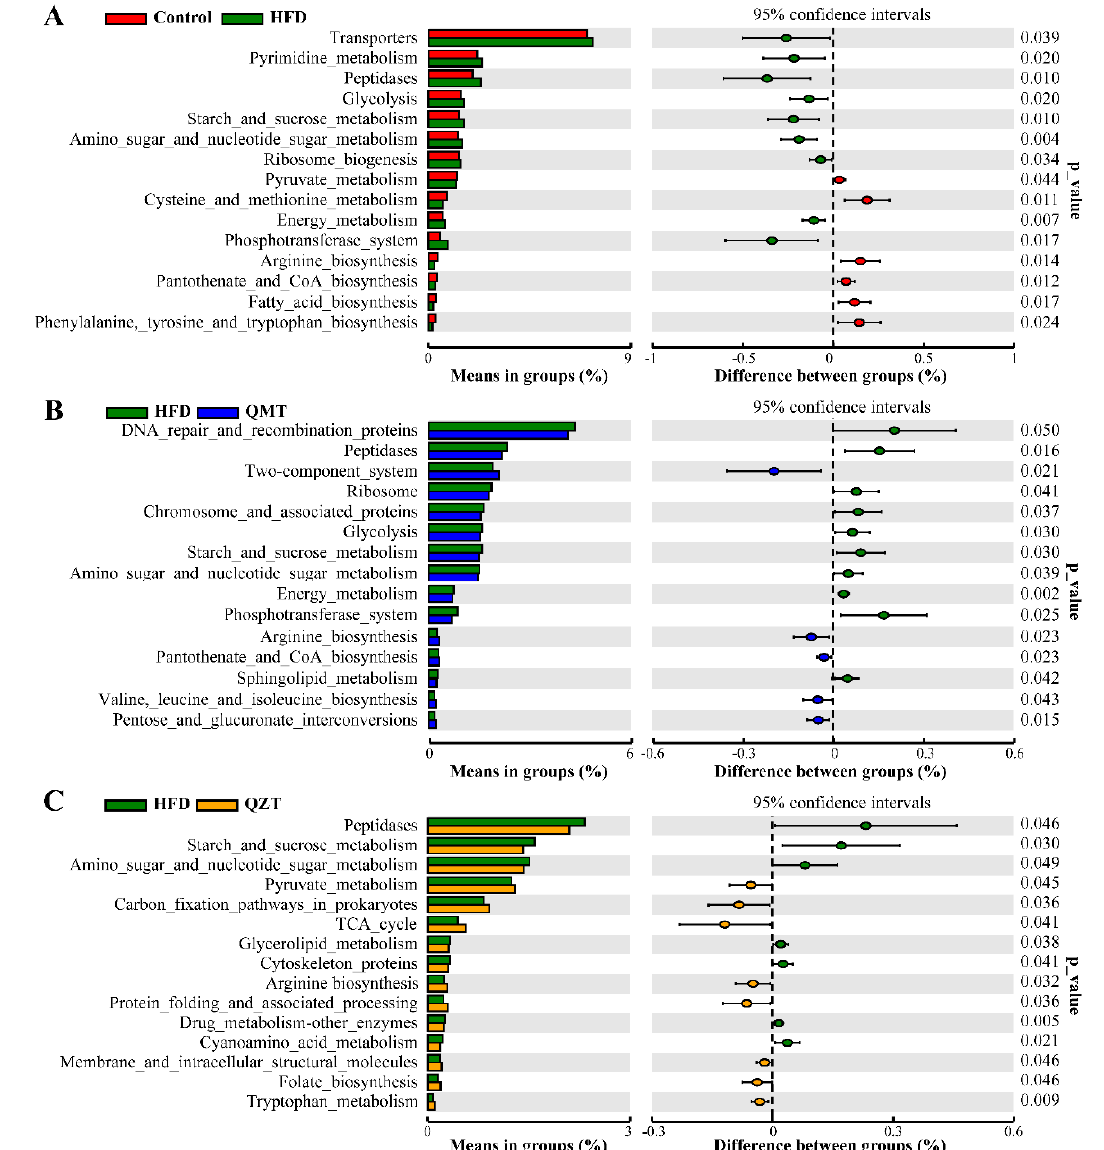
Figure 6. Effects of HFD ( A ), QMTe ( B ), and QZTe ( C ) intervention on microbial community functions predicted by Tax4Fun. TCA_cycle, tricarboxylic acid